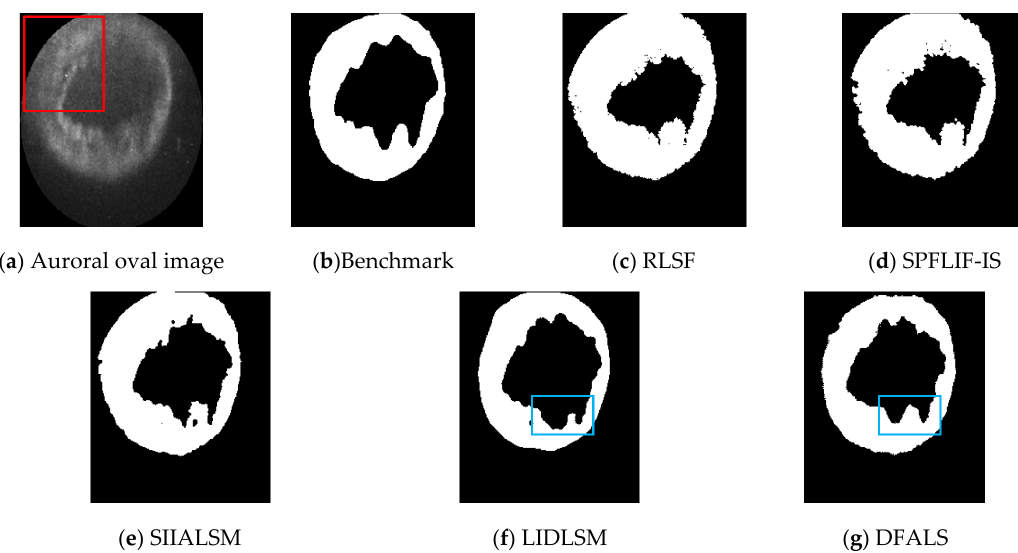
Figure 11. The segmentation results of different methods. ( a ) UVI image captured by the Polar satellite on Jul 31 1997 09:34:48. ( b ) The benchmark annotated by experts manually. ( c ) The segmentation result of the region-based active contour model via local similarity factor (RLSF). ( d ) The segmentation result of the improved signed pressure force and local image fitting based image segmentation (SPFLIF-IS) method. ( e ) The segmentation result of the shape-initialized and intensity-adaptive level set method (SIIALSM). ( f ) The segmentation result of LIDLSM. ( g ) The segmentation result of DFALS. The second auroral oval image contains low contrast region as marked by the red rectangle in